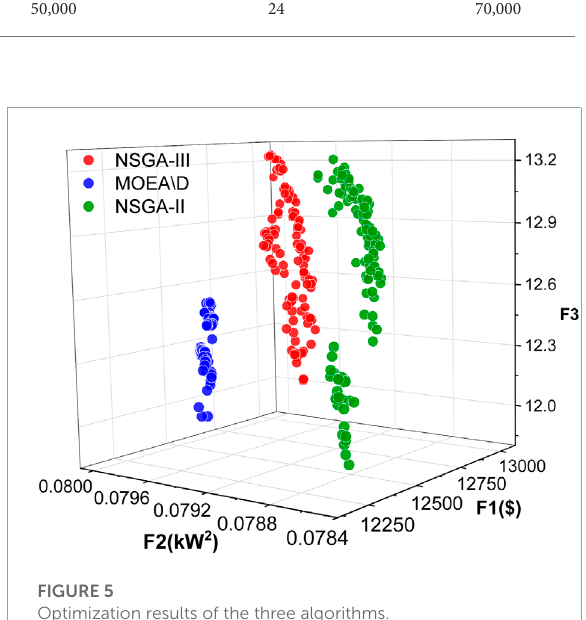
FIGURE 5 Optimization results of the three